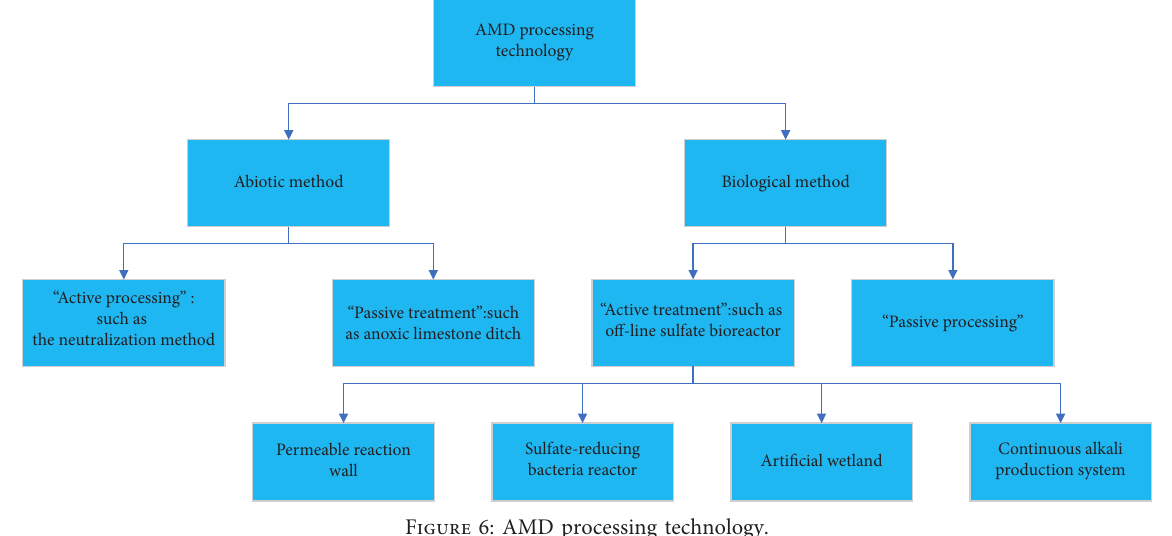
Figure 6: AMD processing technology.